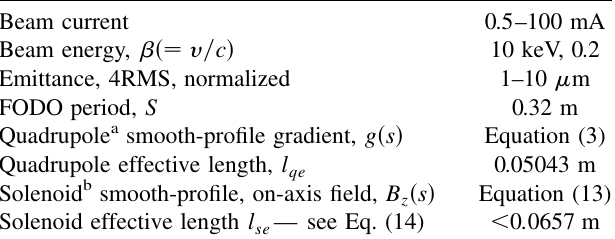
TABLE I. Beam and lattice parameters in UMER.